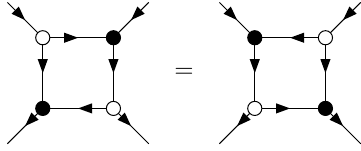
Figure 2 . Square move for N = 7 on-shell